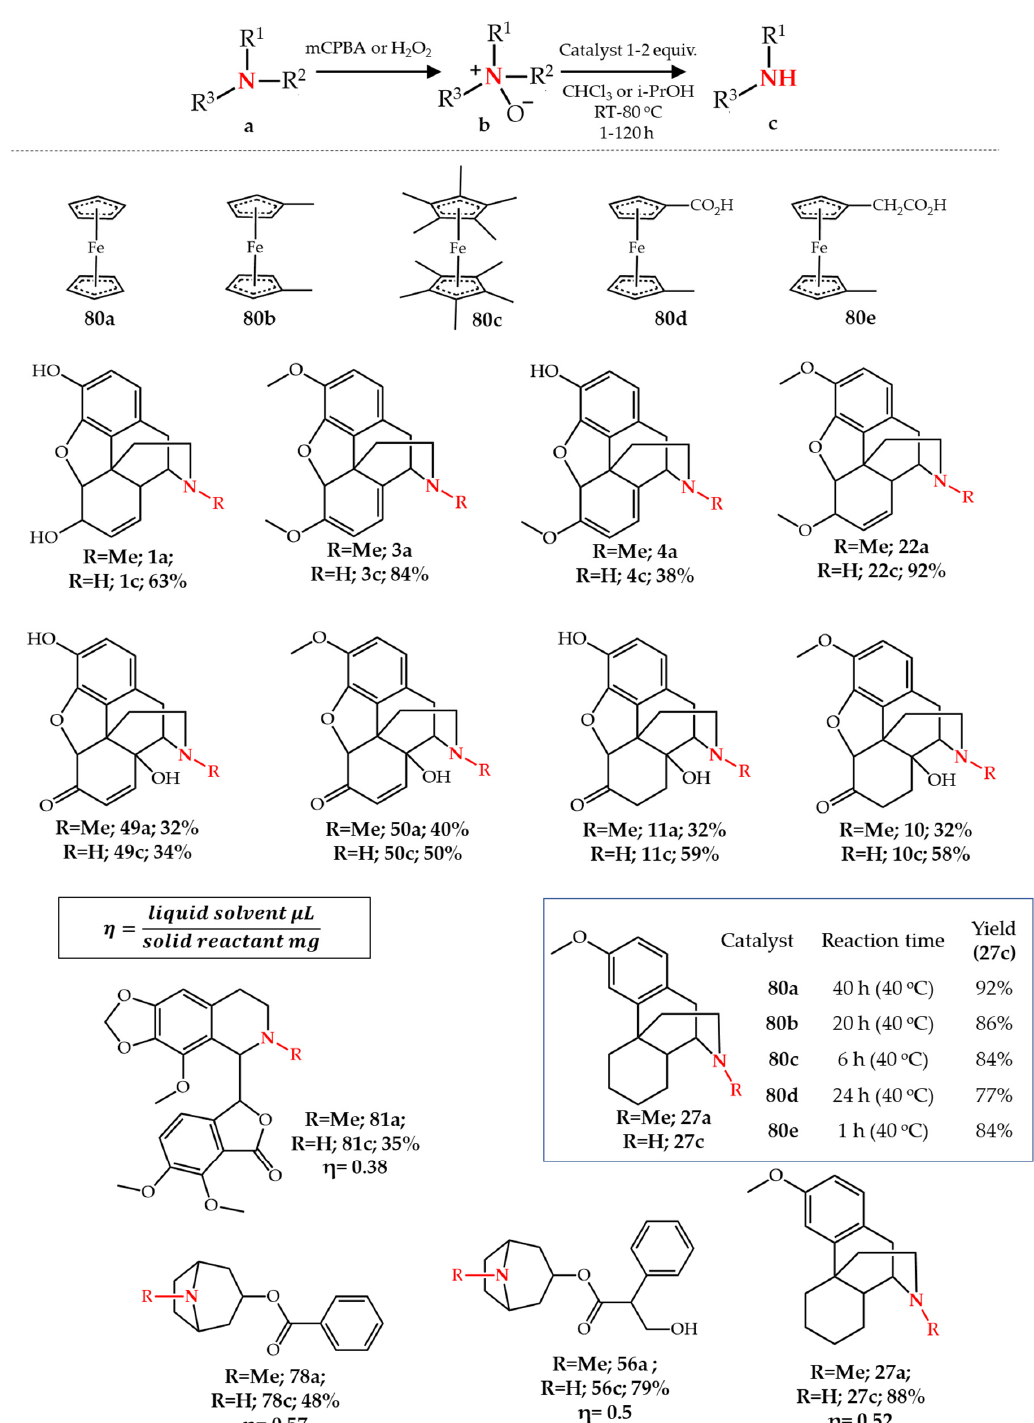
Figure 11. Fe-catalyzed N- demethylation of various Figure 11. Fe ‐ catalyzed N ‐ demethylation of various alkaloids. An interesting iron ‐ based modified ‐ Polonovski reaction using liquid assisted grind ‐ ing (LAG) mechanochemistry was developed by Awalt et al. [96]. As organic solvents